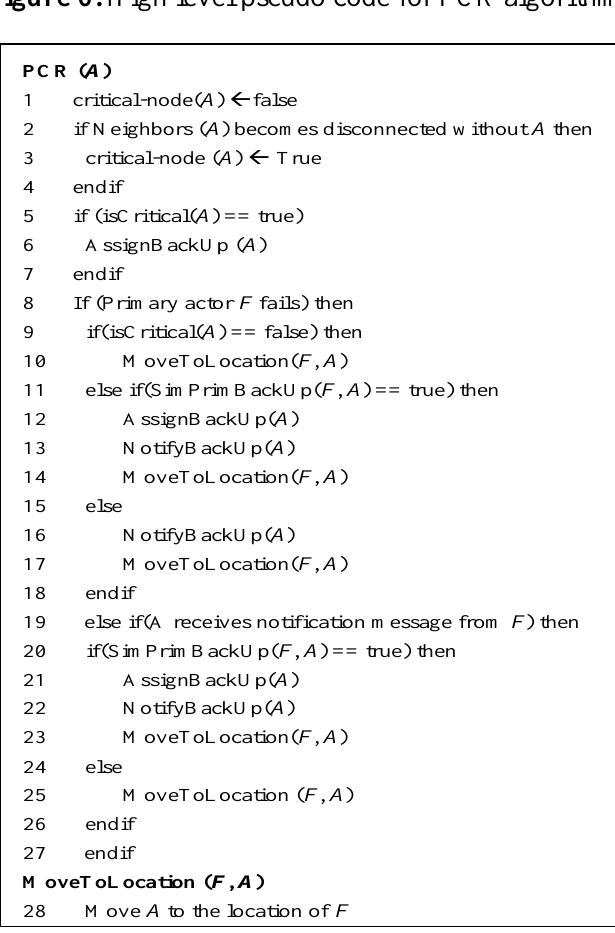
Figure 6. High level pseudo code for PCR